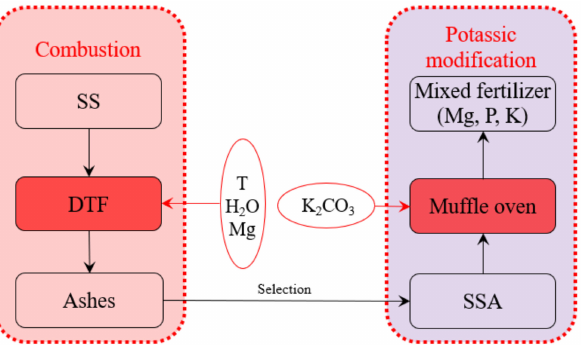
Figure 1. A method for thermal recovery of phosphorous in SS as fertilizer (DTF—drop tube furnace;